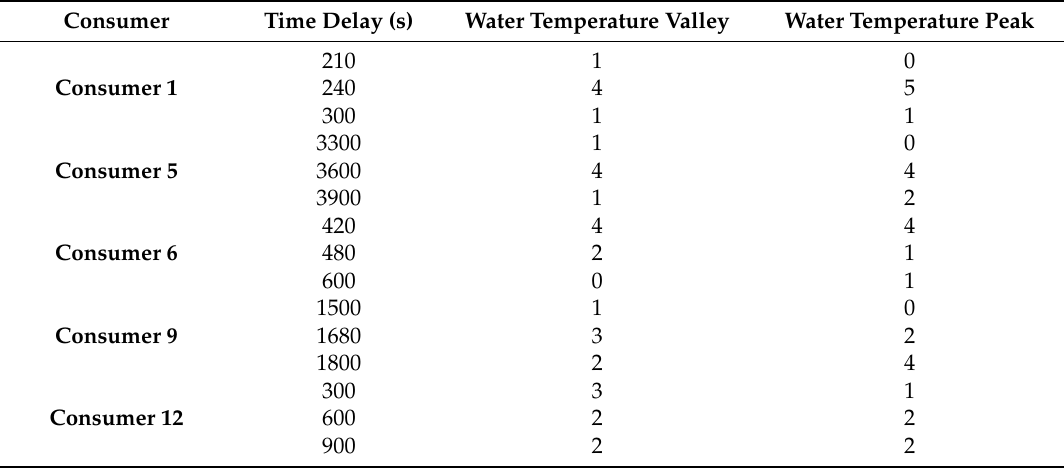
Table 4. Frequency statistics of the time delay of consumers.